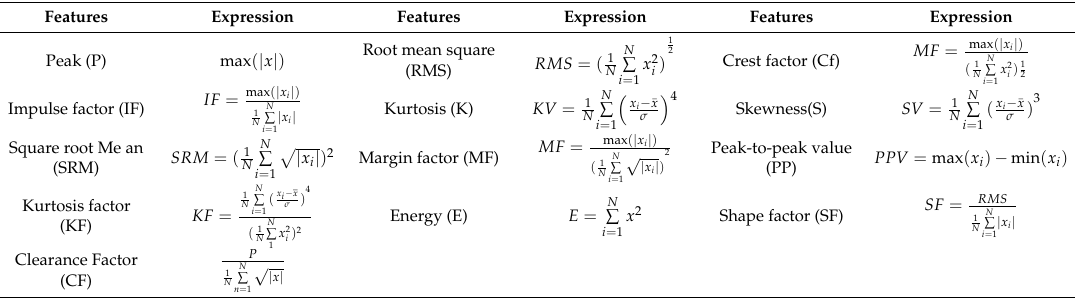
Table 1. Statistical time domain features (x is the acoustic emission